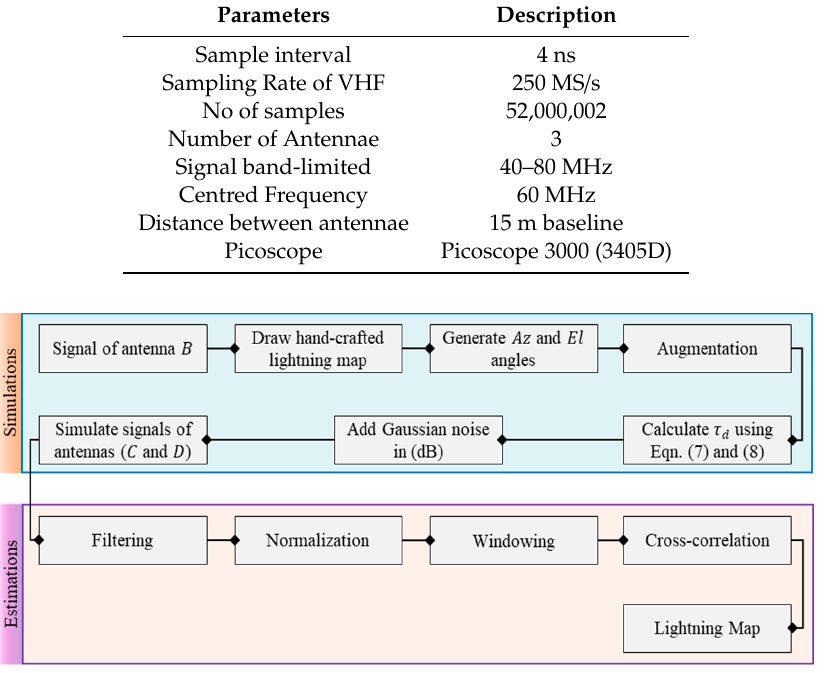
Figure 4. The procedure of simulating lightning signals.